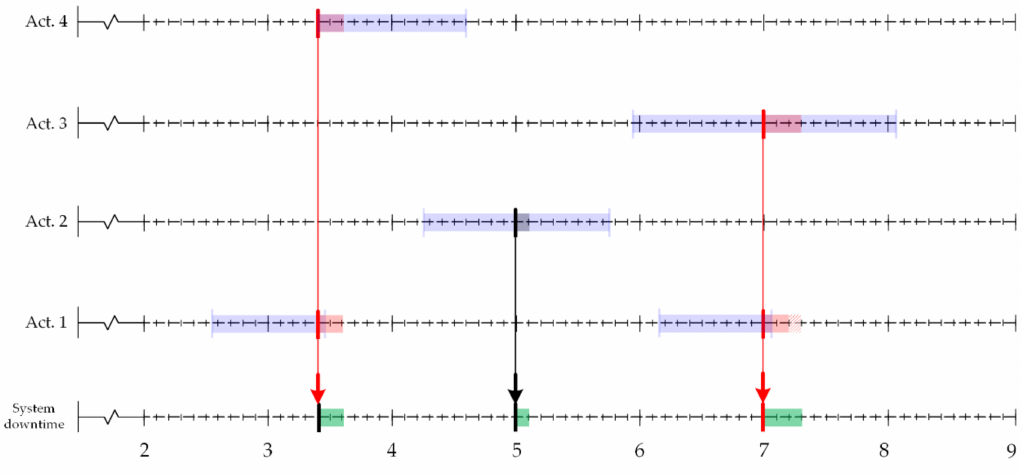
Figure 6. Application example. Schematic representation of the optimal solution for the instance.